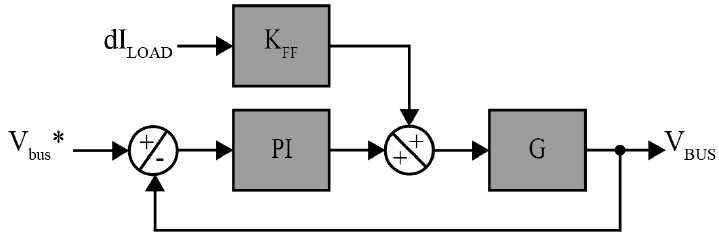
Figure 3. V bus control